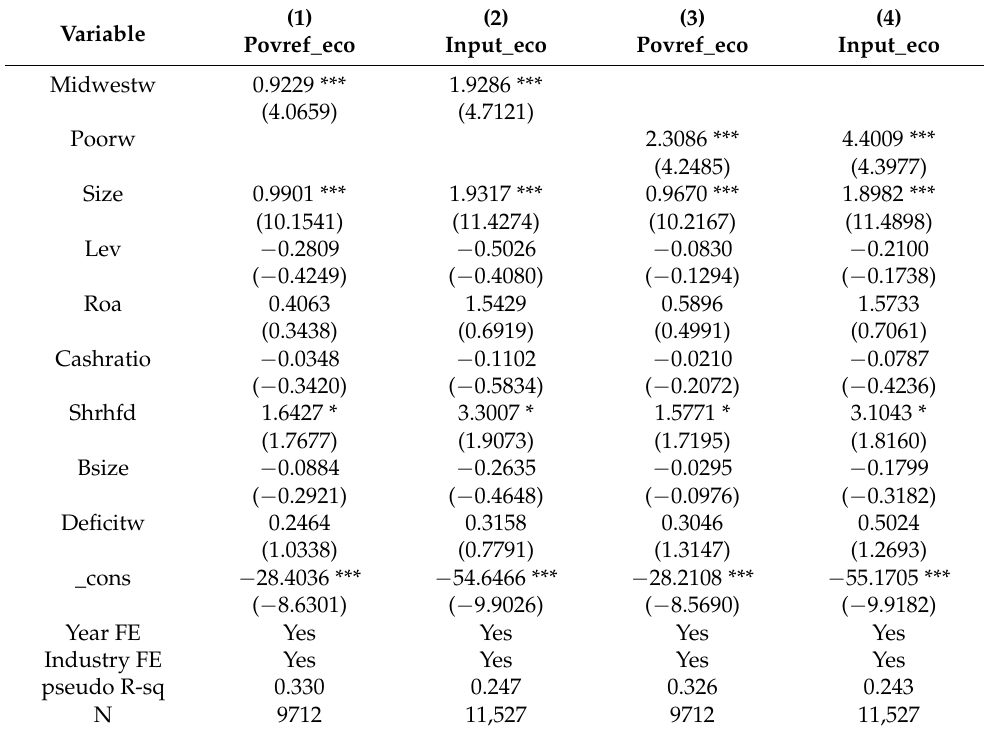
Table 6. Robustness tests: attribution criteria with office address.